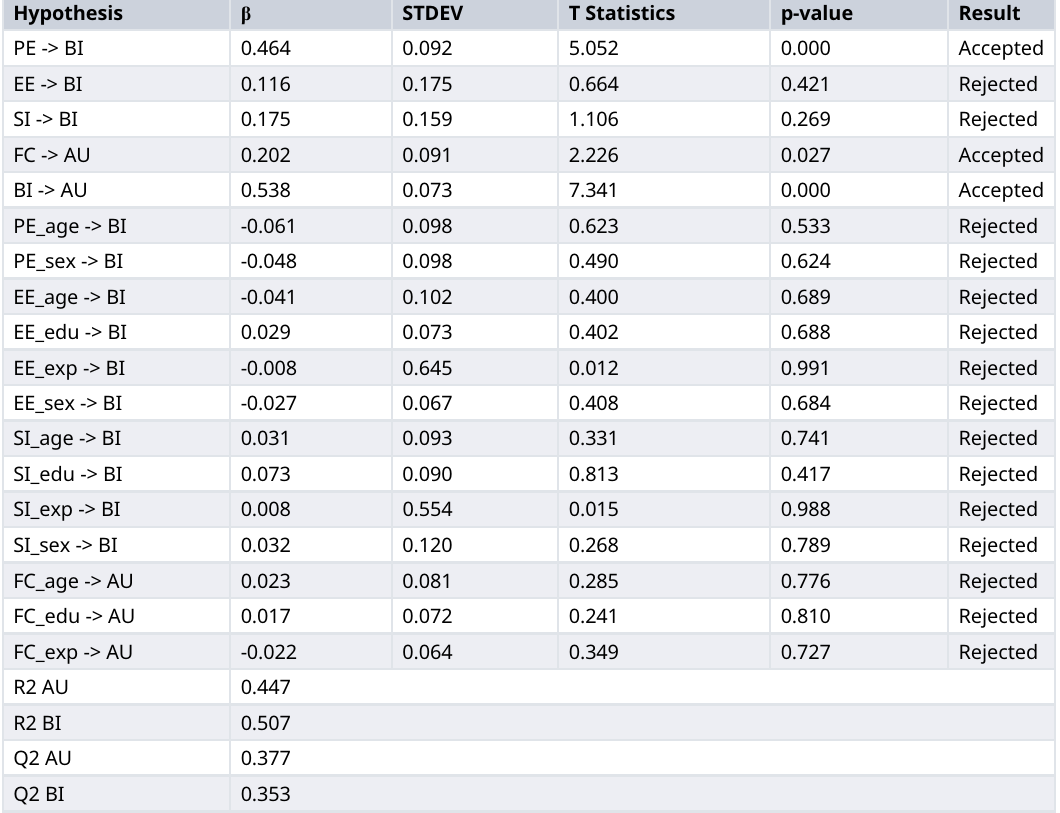
Table 4. Regression